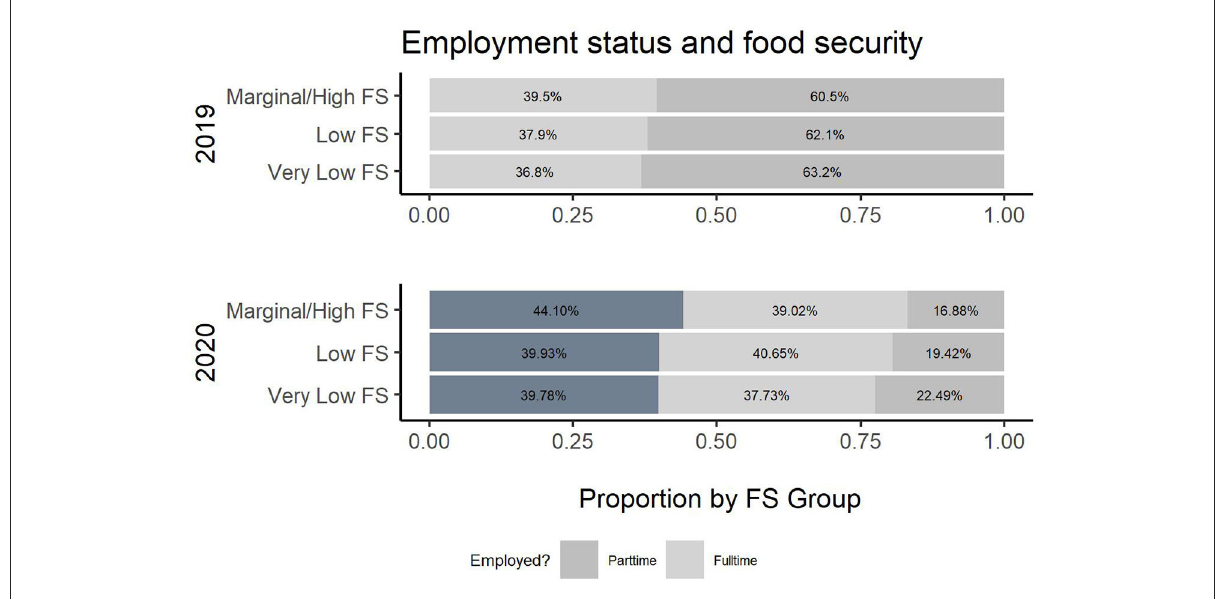
FIGURE2 Employment status and food security.